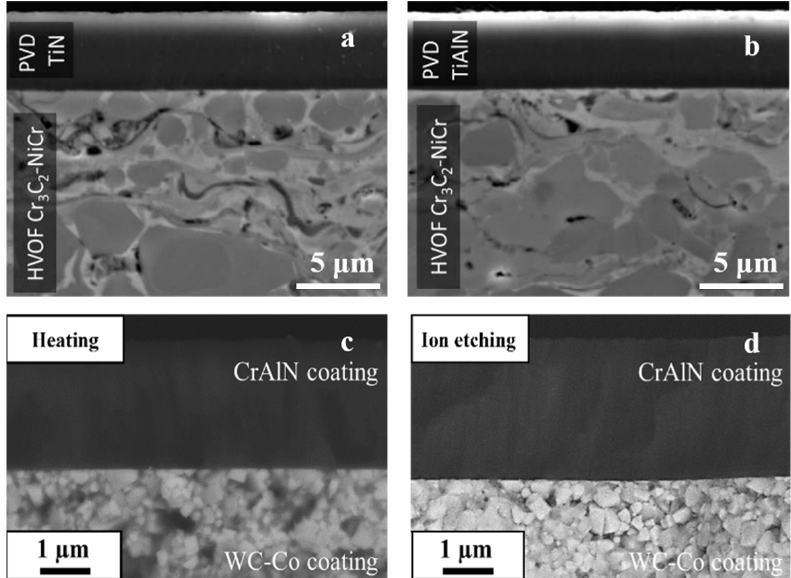
Figure 4. Cross-sectional microstructure of HVOF-PVD duplex coatings: the ( a ) Cr 3 C 2 -NiCr/TiN, ( b ) Cr 3 C 2 -NiCr/TiAlN, ( c ) WC-Co-heating/CrAlN and ( d ) WC-Co-etching/CrAlN. Copyright Elsevier, 2019. Reprinted with permission from Ref. [50]. Copyright Elsevier, 2017. Reprinted with permis- sion from Ref. [62].